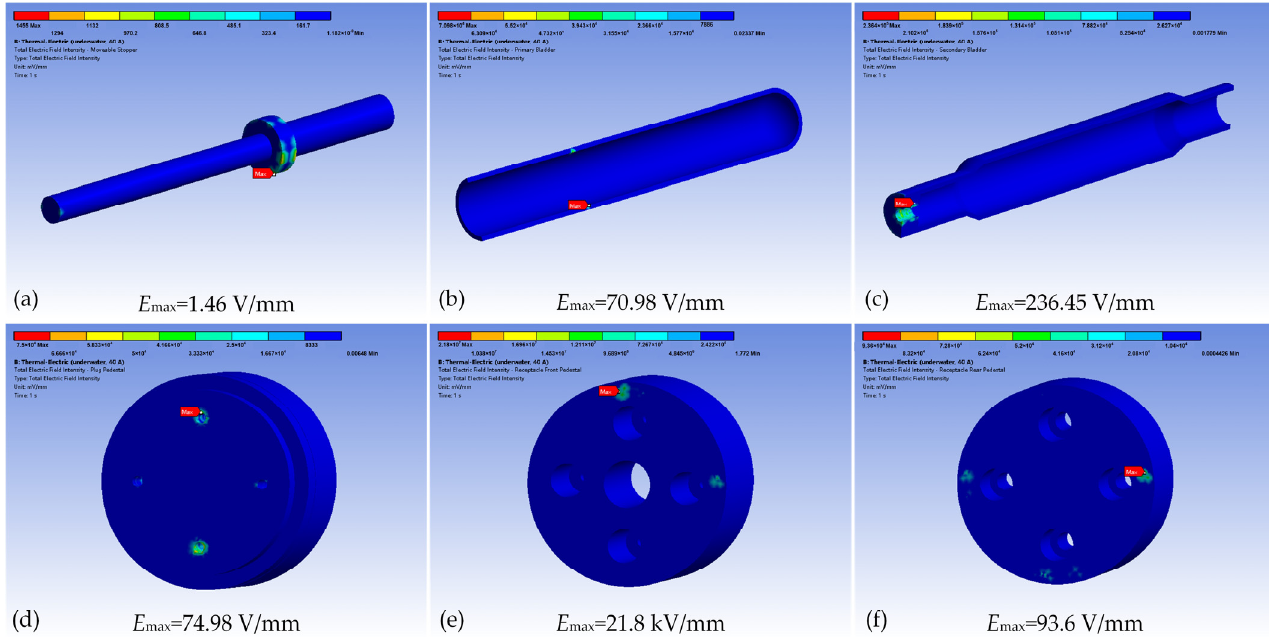
Figure 9. The voltage distribution of the main insulating components in an underwater environment (the ambient temperature is 5 °C): ( a ) moveable stopper, ( b ) primary resilient bladder, ( c ) secondary resilient bladder, ( d ) plug pedestal, ( e ) receptacle front pedestal, and ( f ) receptacle rear pedestal.